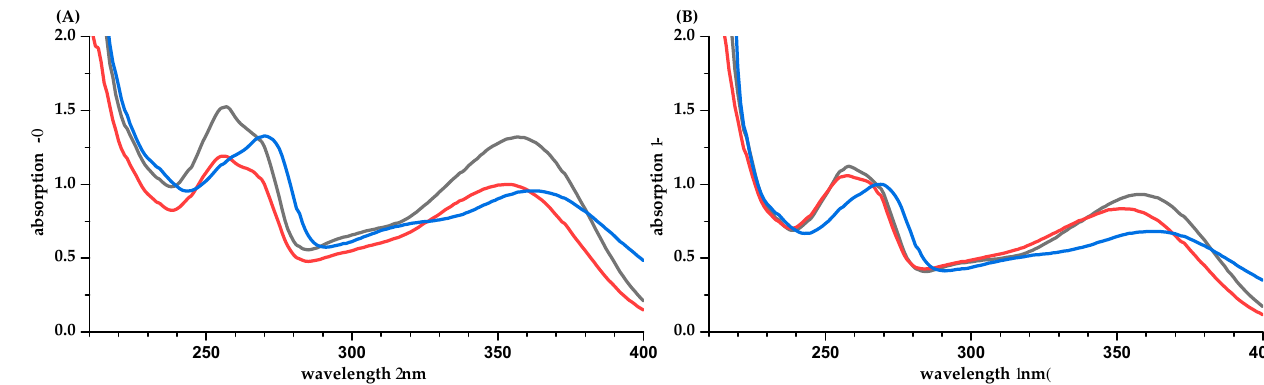
Figure 3. UV-spectra of IRH-3-rut ( A ) and Q-3-glc ( B ) in water/methanol (50/50, v/v , black), water (red), and phosphate buffer pH 7 (blue). Concentrations are different for the two flavonoids but similar between the solvents.